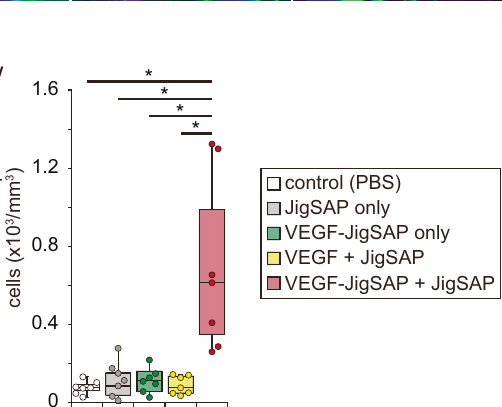
RADA16, we injected JigSAP and RADA16 peptides incorporat- ing VEGF-JigSAP and VEGF-RADA16, respectively. In this experiment, to exclude the possibility that VEGF-JigSAP + JigSAP enhanced functional recoveries only in the dMCAO model, we used a photothrombotic model. VEGF-JigSAP + JigSAP also improved behavioral recovery in the photothrombo- tic model, while VEGF-RADA16 + RADA16 did not (Fig. 6b).